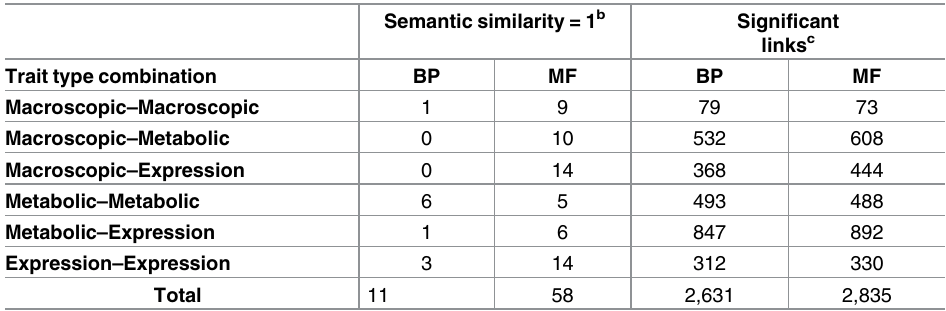
Table 3. Semantic similarity between different types of traits a .